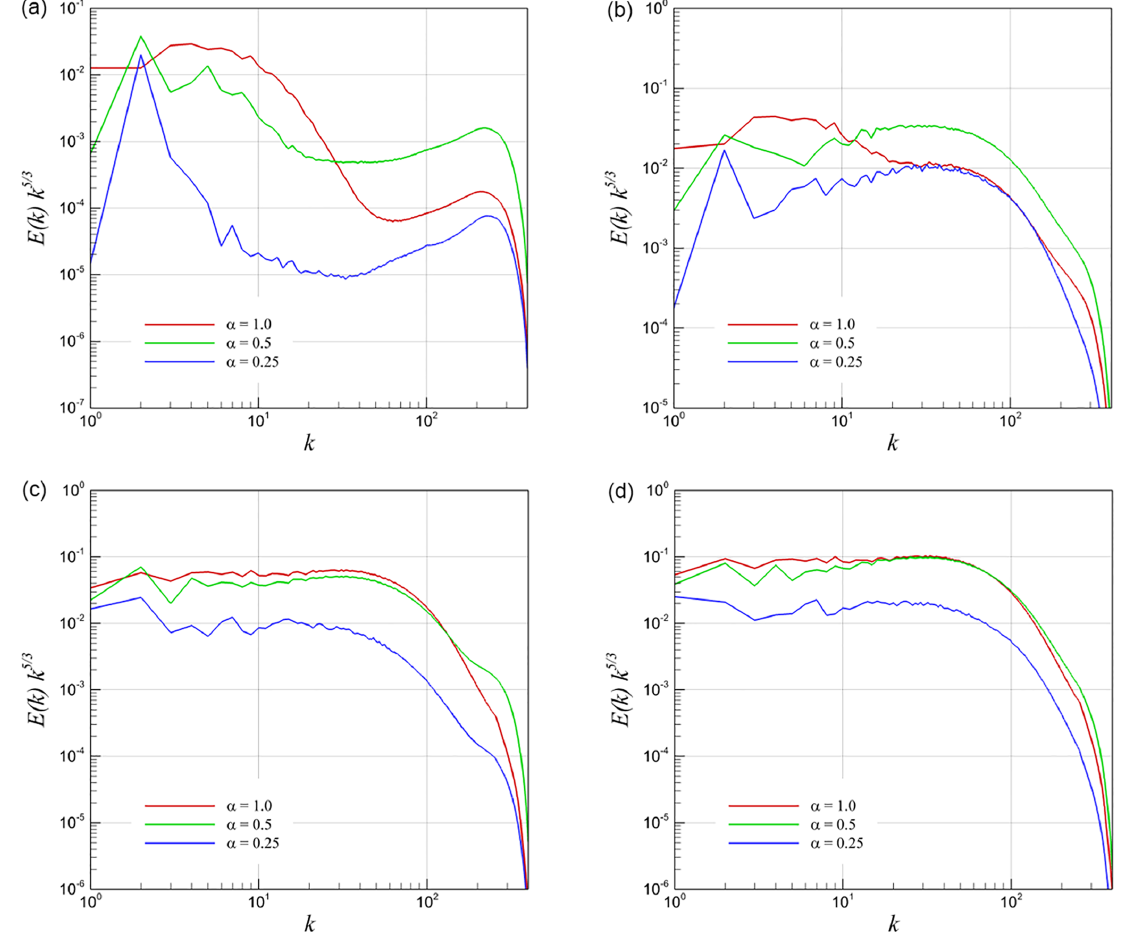
Figure 15. Helmholtz decomposition of energy spectra into compressive (curl-free) and solenoidal (divergence-free) parts for 3-D KHI turbulence. (a) Compensated compressive spectra from u , (b) compensated compressive spectra from ω = spectra from u , and (d) compensated solenoidal spectra from ω =